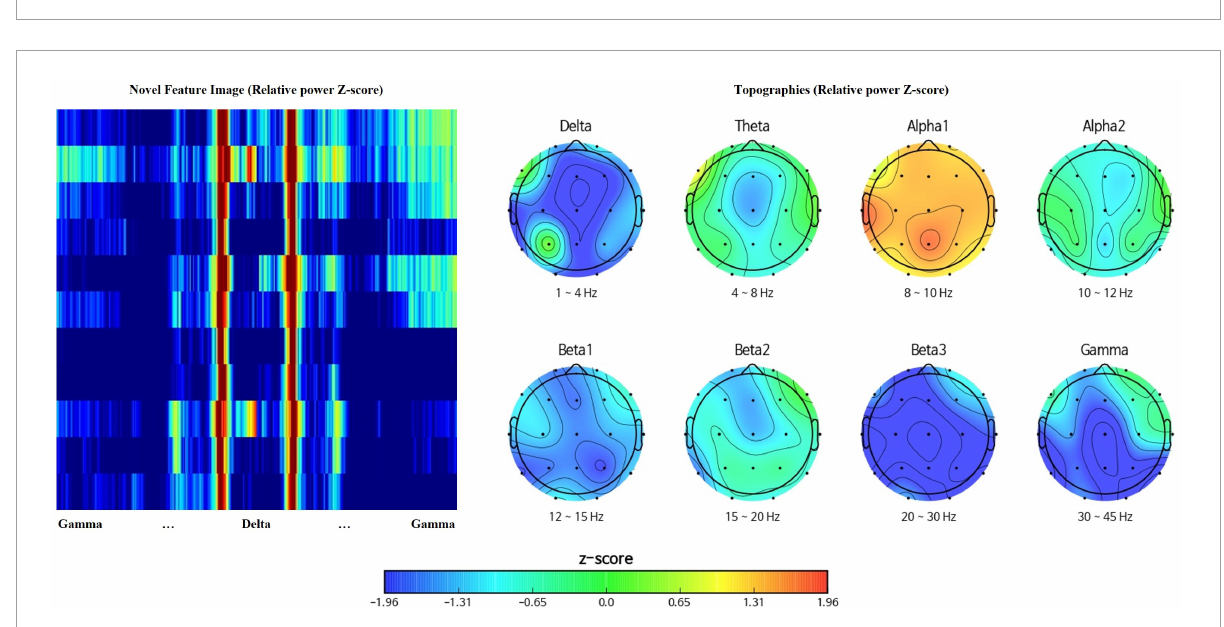
FIGURE2 Comparison between the novel feature image and traditional topographies showing clear spatiotemporal